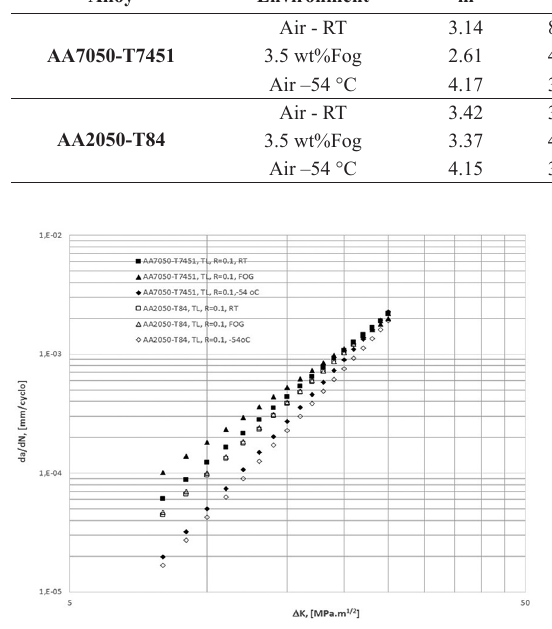
Figure 8. Schematic illustration of the stress-assisted dissolution mechanism near the crack tip. Figure adapted from Komai 16 and Ford 18 .